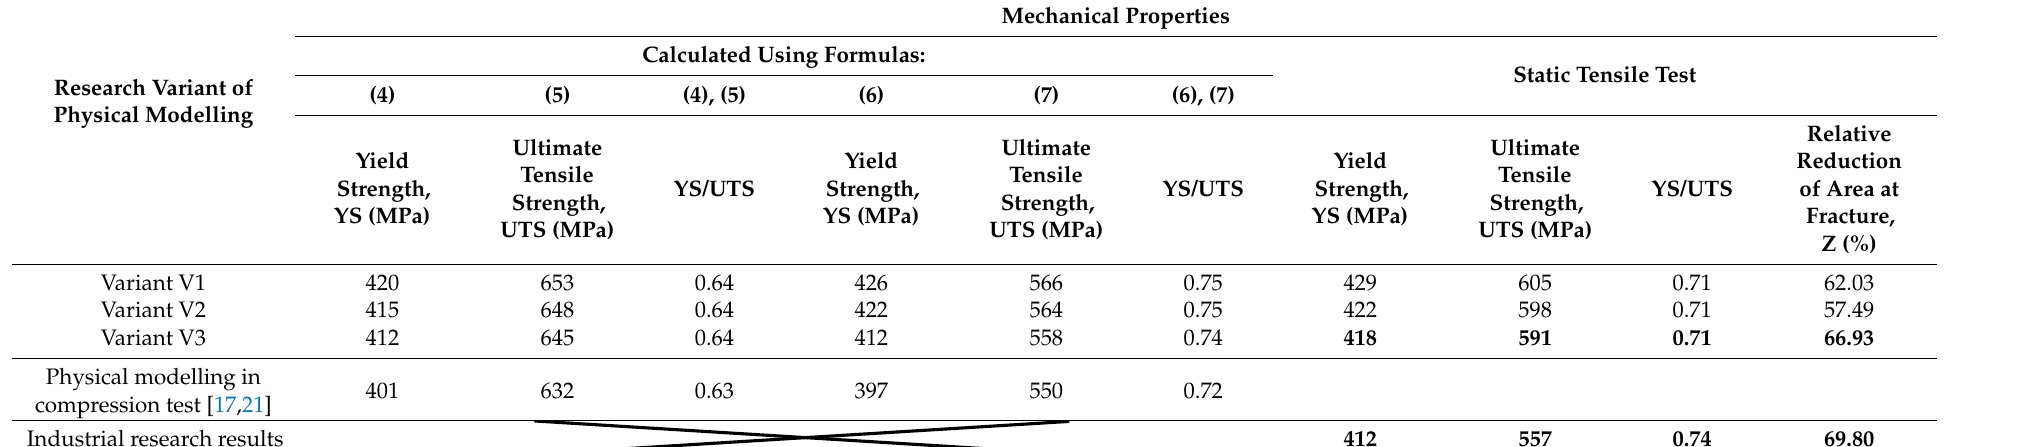
Table 7. Measurement results of selected mechanical properties of 20MnB4 steel.